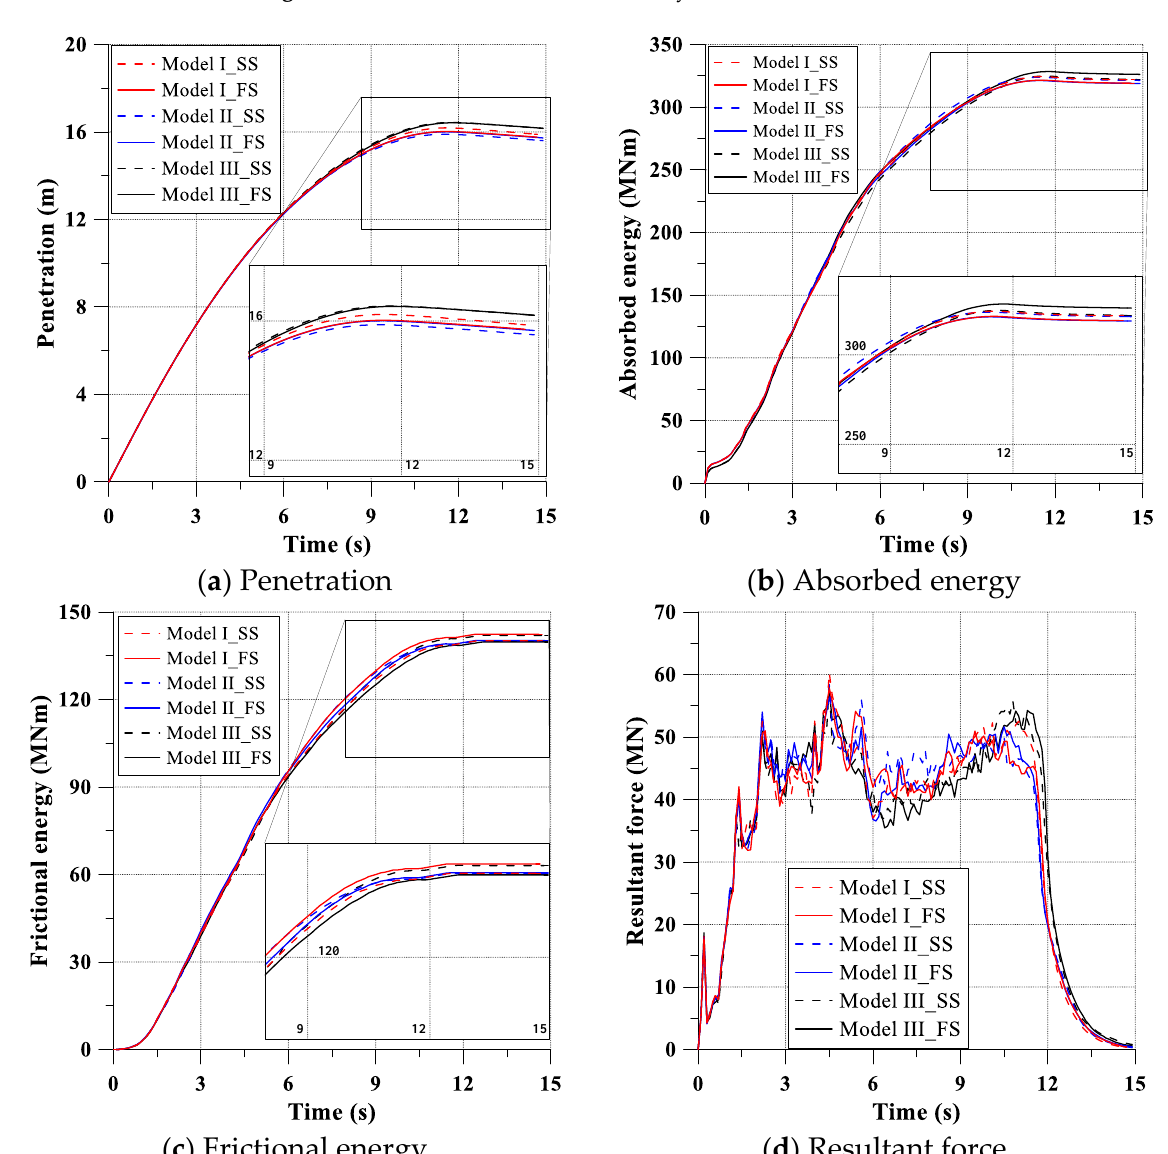
Figure 5. Effects of the extent of analysis and boundary conditions on the structural responses. At both ends of Models II, there was no strong structural member in the breadth direction, such as a bulkhead and transverse frame. Thus, Model II was not stiffened and